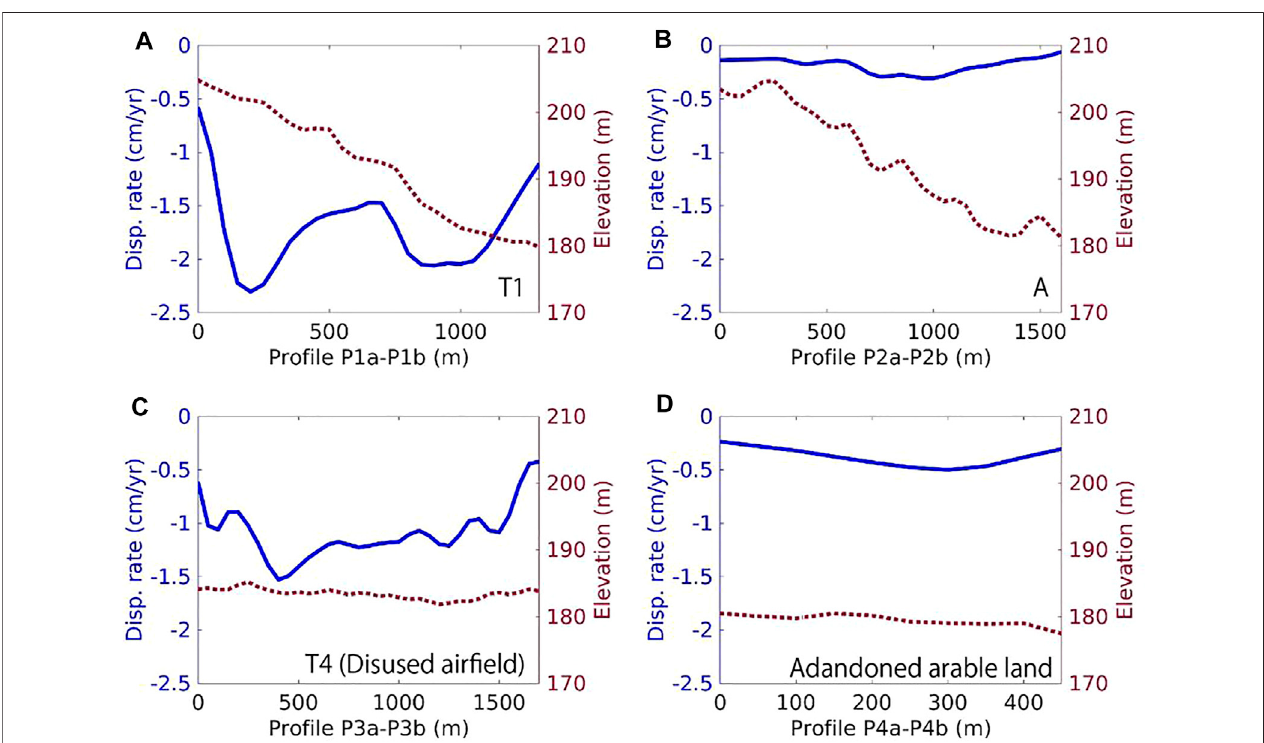
FIGURE 3 | Comparison of the surface displacement rate and elevation along the transect lines P1-P4 in Figure 2B .